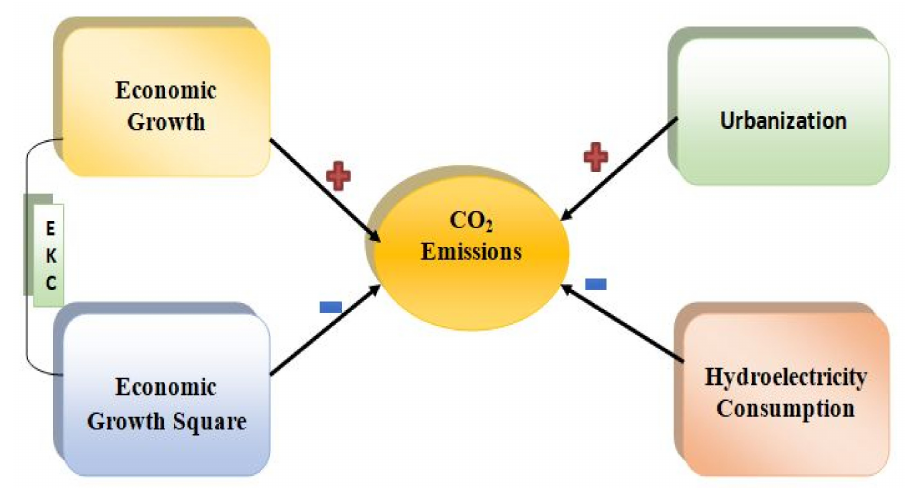
Figure 3. Graphical outcomes of the ARDL long-run estimation.